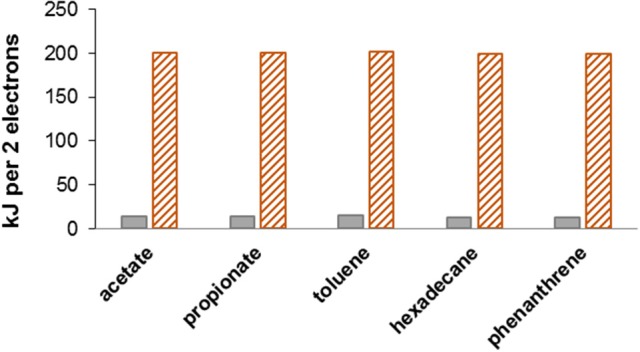
Nitrate (hatched orange bars) is a better electron acceptor than sulfate (gray bars). Energy yield (ΔG°′ in kJ/2electrons) is essentially independent of the type of organic electron donor used. In this example nitrate reduction is via denitrification to N2 (gas), while sulfate is reduced to sulfide. Partial reactions: acetate oxidation, CH3COO− + H+ + 2H2O → 2CO2 + 8[H], ΔG°′ = 14.3 kJ/2electrons; propionate oxidation, CH3CH2COO− + H+ + 4H2O → 3CO2 + 14[H], ΔG°′ = 14.2 kJ/2electrons; toluene oxidation, C6H5CH3 + 14H2O → 7CO2 + 36[H], ΔG°′ = 15.4 kJ/2electrons; hexadecane oxidation, C16H34 + 32H2O → 16CO2 + 98[H], ΔG°′ = 12.9 kJ/2electrons; phenanthrene oxidation, C14H10 + 28H2O → 14CO2 + 66[H], ΔG°′ = 13.4 kJ/2electrons; denitrification, 2H+ + 2NO3- + 10[H] → N2 + 6H2O, ΔG°′ = −224.1 kJ/2electrons; sulfate reduction, 2H+ + SO42- + 8[H] → H2S + 4H2O, ΔG°′ = −38.0 kJ/2electrons; Gf° values for toluene and hexadecane are from Helgeson et al. (1998); Gf° for phenanthrene is from Dolfing et al. (2009).